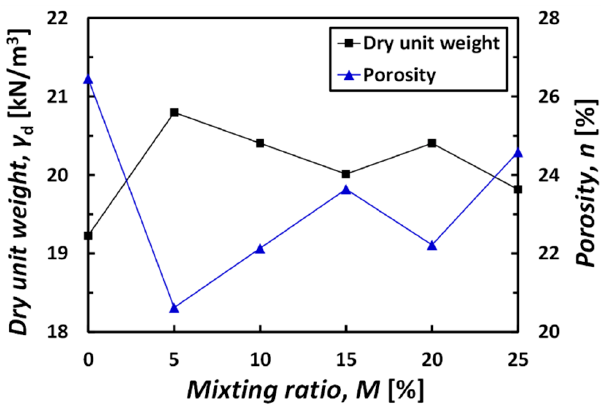
Figure 3. Dry unit weight and porosity of mixtures.